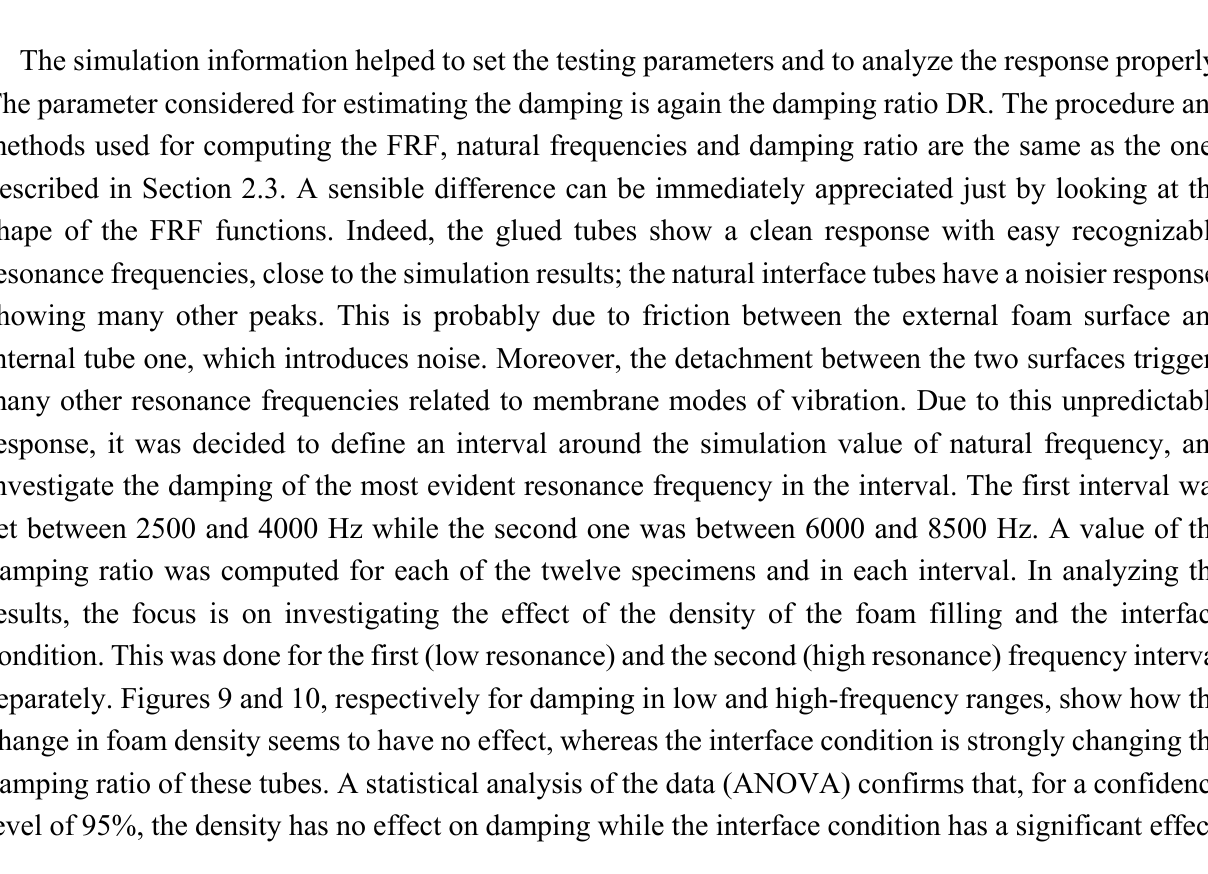
Figure 8. Value of the first resonance frequency of filled tubes scaling as a function of the density of the foam filling (analytical law): 2 mm of titanium external skin and 38 mm of entire tube